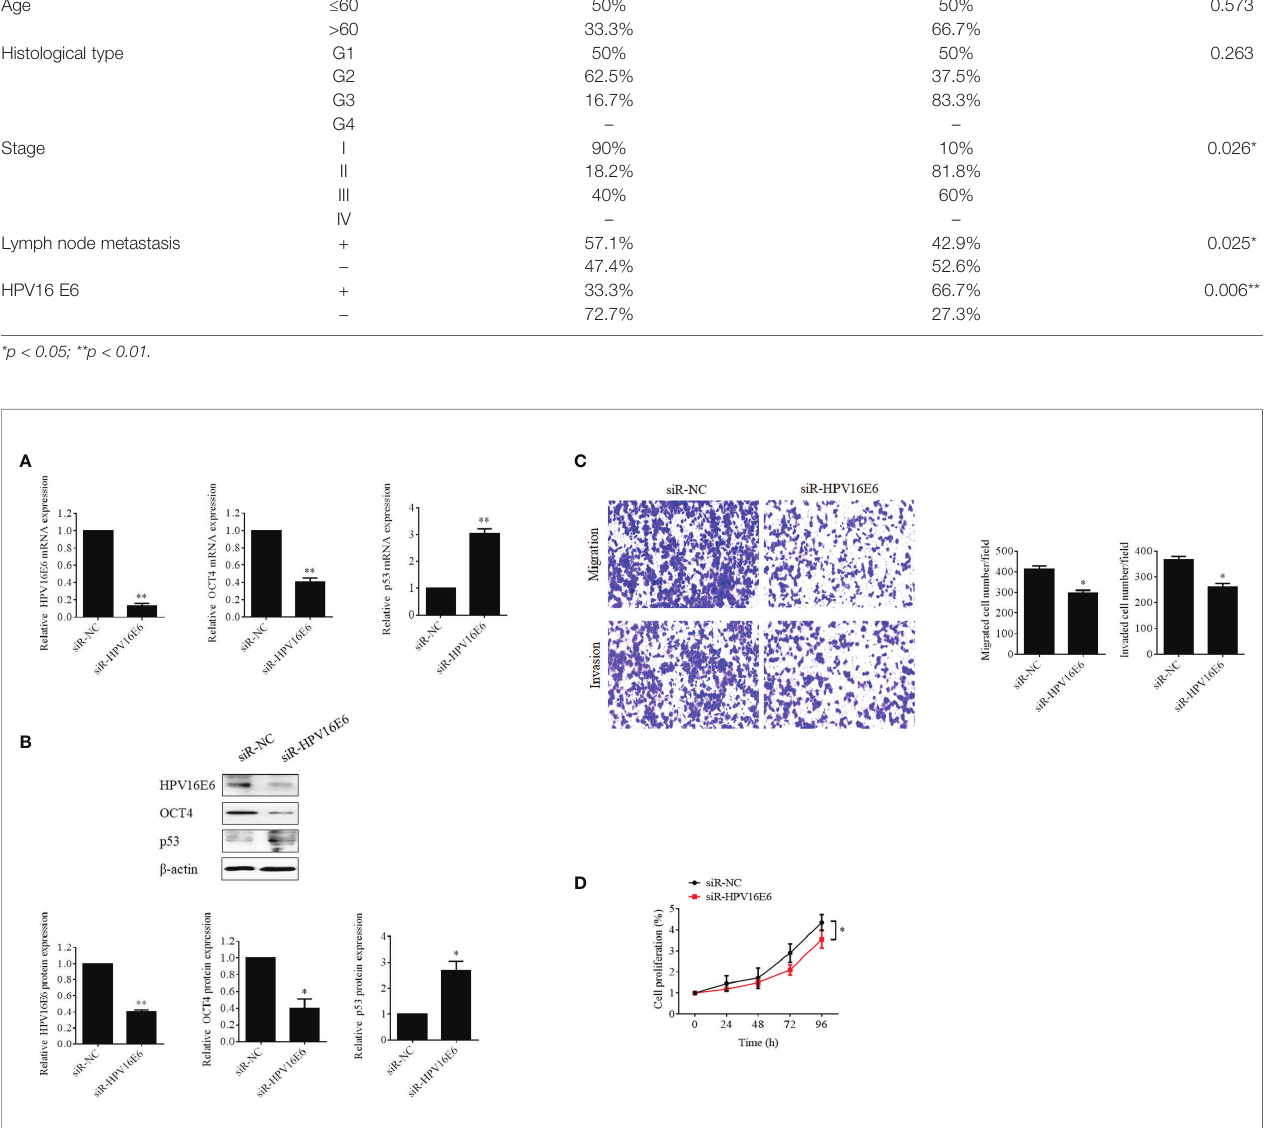
FIGURE 2 | Silencing of HPV16 E6 repressed OCT4 expression, cell proliferation, migration, and invasion and stimulated p53 expression in human cervical cancer cells. (A) The SiHa cells were transfected with HPV16 E6-siRNA or control siRNA, for 24 h. Then, HPV16 E6, OCT4, and p53 mRNA levels were determined by RT- qPCR. (B) Then, E6, OCT4, and p53 protein levels were detected by Western blot in cells treated as in (A) . (C) Transwell assay analysis of migration and invasion abilities in the human cervical cancer cell line SiHa transfected with HPV16 E6-siRNA or control siRNA. (D) MTT assay analysis of proliferation ability in the human cervical cancer cell line SiHa transfected with HPV16 E6-siRNA or control siRNA. * p < 0.05, ** p < 0.01 vs. control.